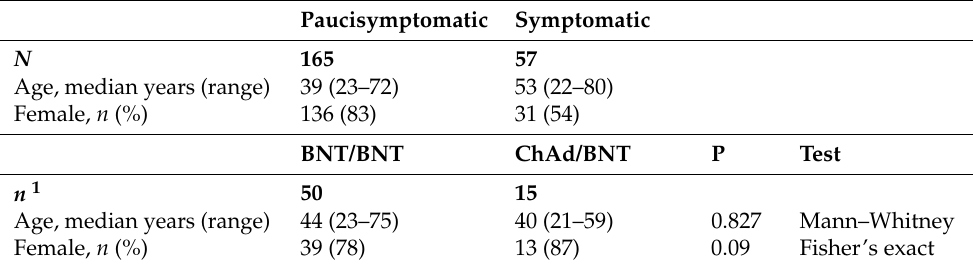
Table 1. Subject